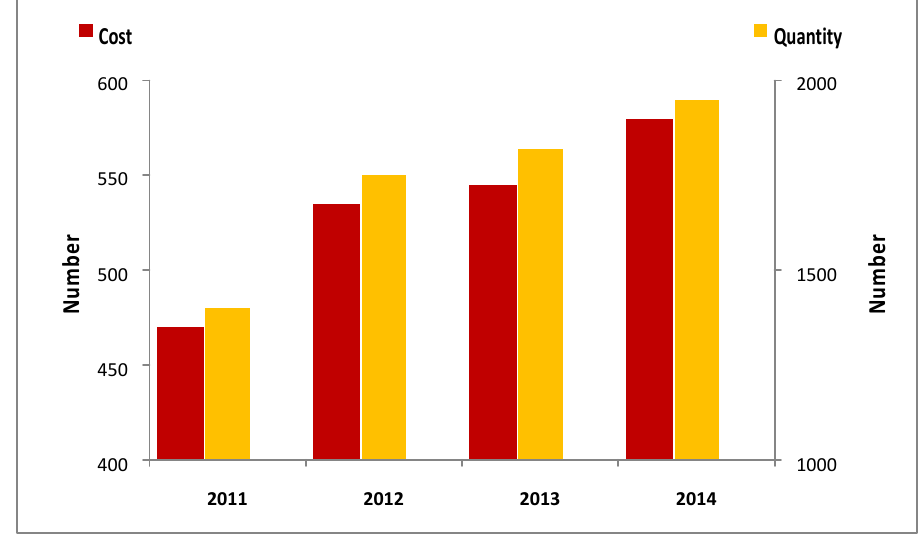
Figure 1. Reimbursed medicines for home treatment and the cost of public expenses (bothin BGN) in Bulgaria; data for 2014 consists of estimates (Source: NHIF Report for